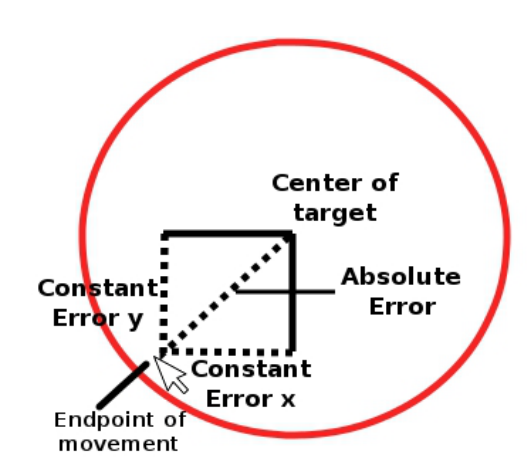
Figure 6. Graphical depiction of movement accuracy